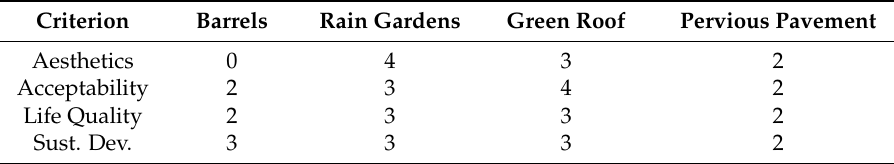
Table 9. BMP social performance